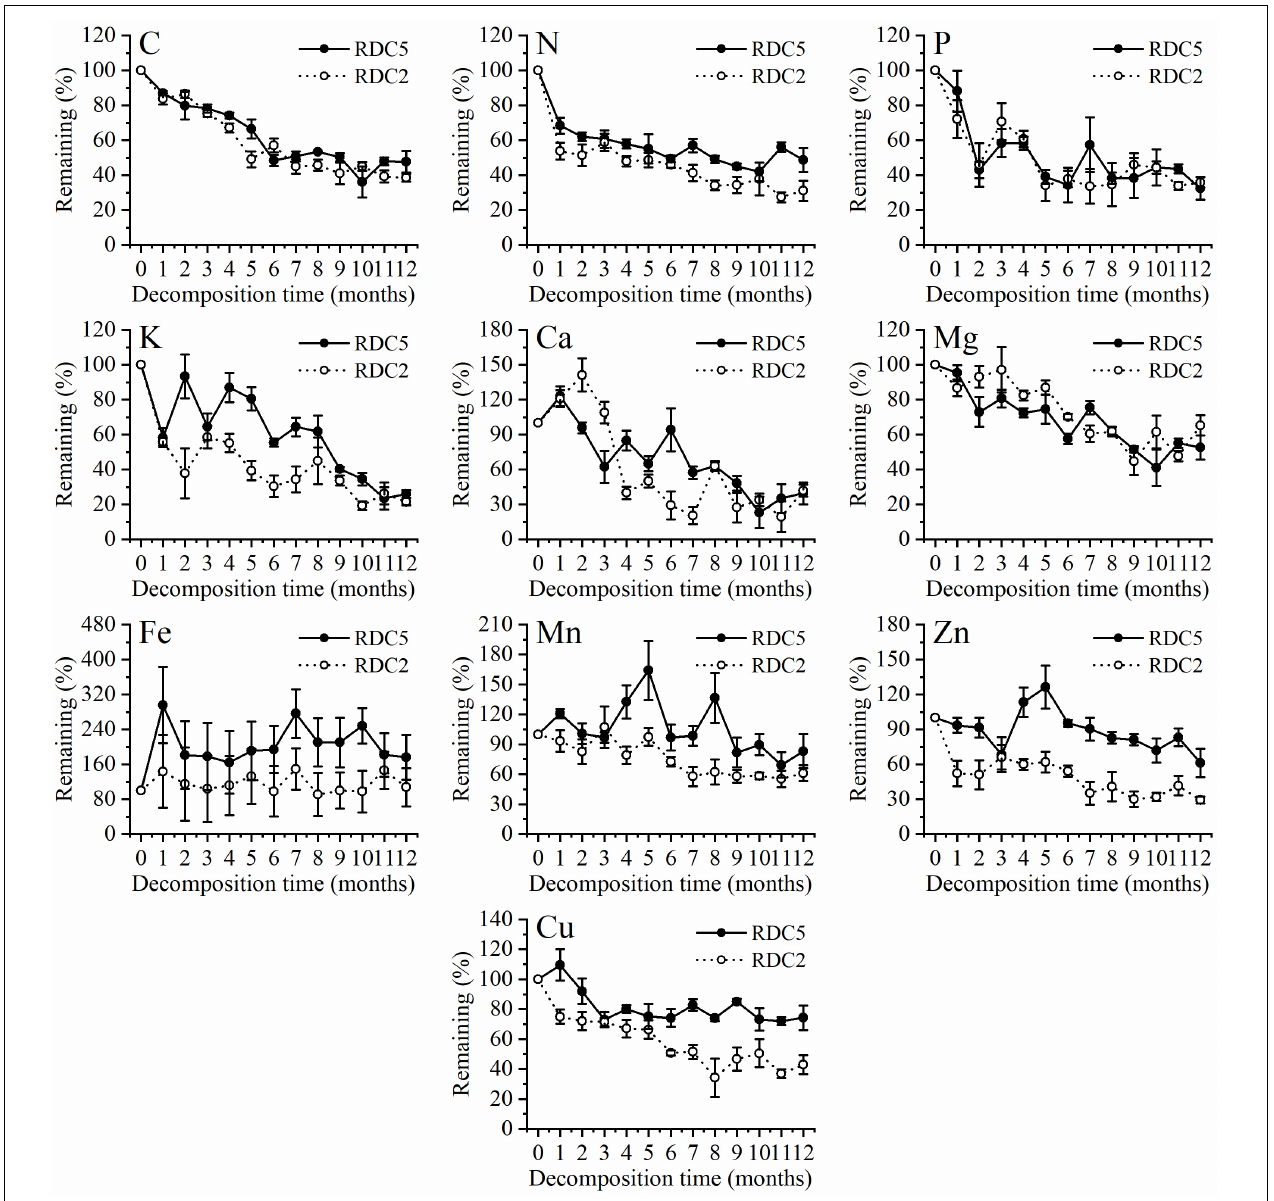
FIGURE 3 | Change trend in element remaining percentage during fine-root